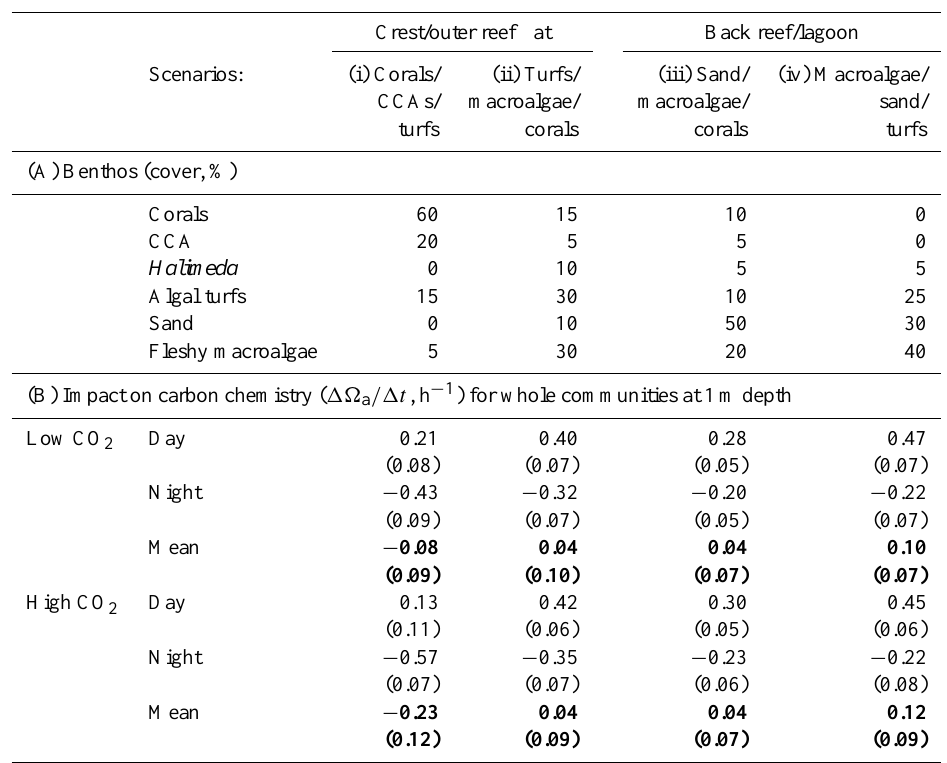
Table 1. Four scenarios for (A) benthic reef community compositions across the shallow-water environments of Heron Reef flat and lagoon, and their (B) predicted impacts on hourly changes in the aragonite saturation state ( 1(cid:127) a /1t h − 1 ) of a 1m deep water column under ambient (350–450µatm) and high (560–700µatm) CO 2 . Effects of flow are omitted so data encompass daily flow variation. Projections assume full vertical mixing and advection only. Estimates of 1(cid:127) a /1t are here the sum of hourly day and night contributions (assuming 12h day:12h night) from the benthic groups based on data in Fig. 5. Means of day and night contributions are given on bold. Standard errors (in brackets) are calculated using Monte Carlo analyses – see